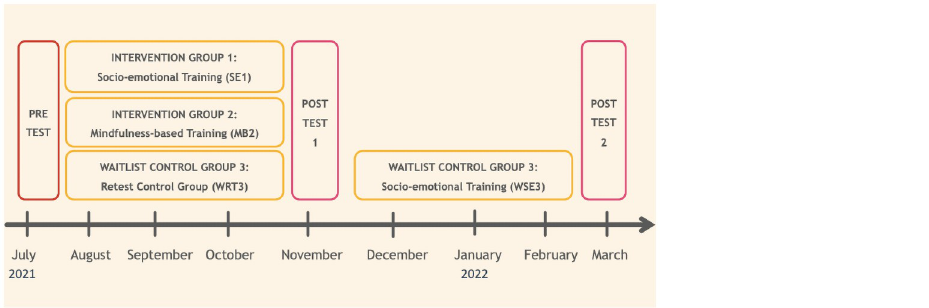
Fig 3. An overview of the study design of phase 2 of the CovSocial project.